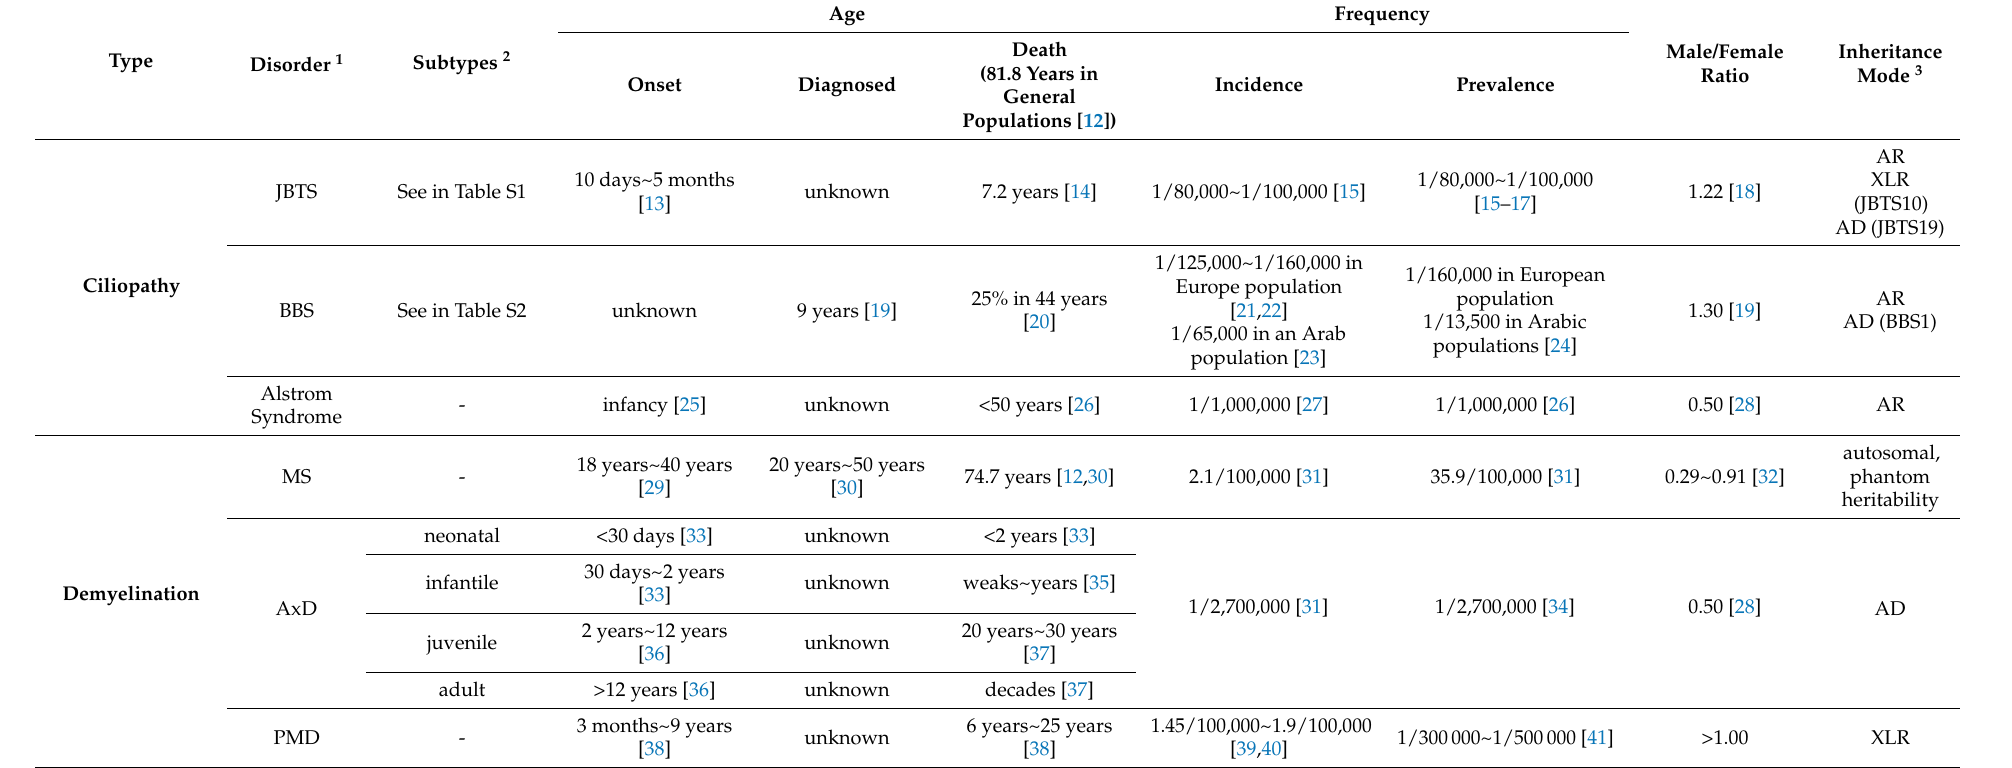
Table 1. Epidemiology of Cerebral Visual